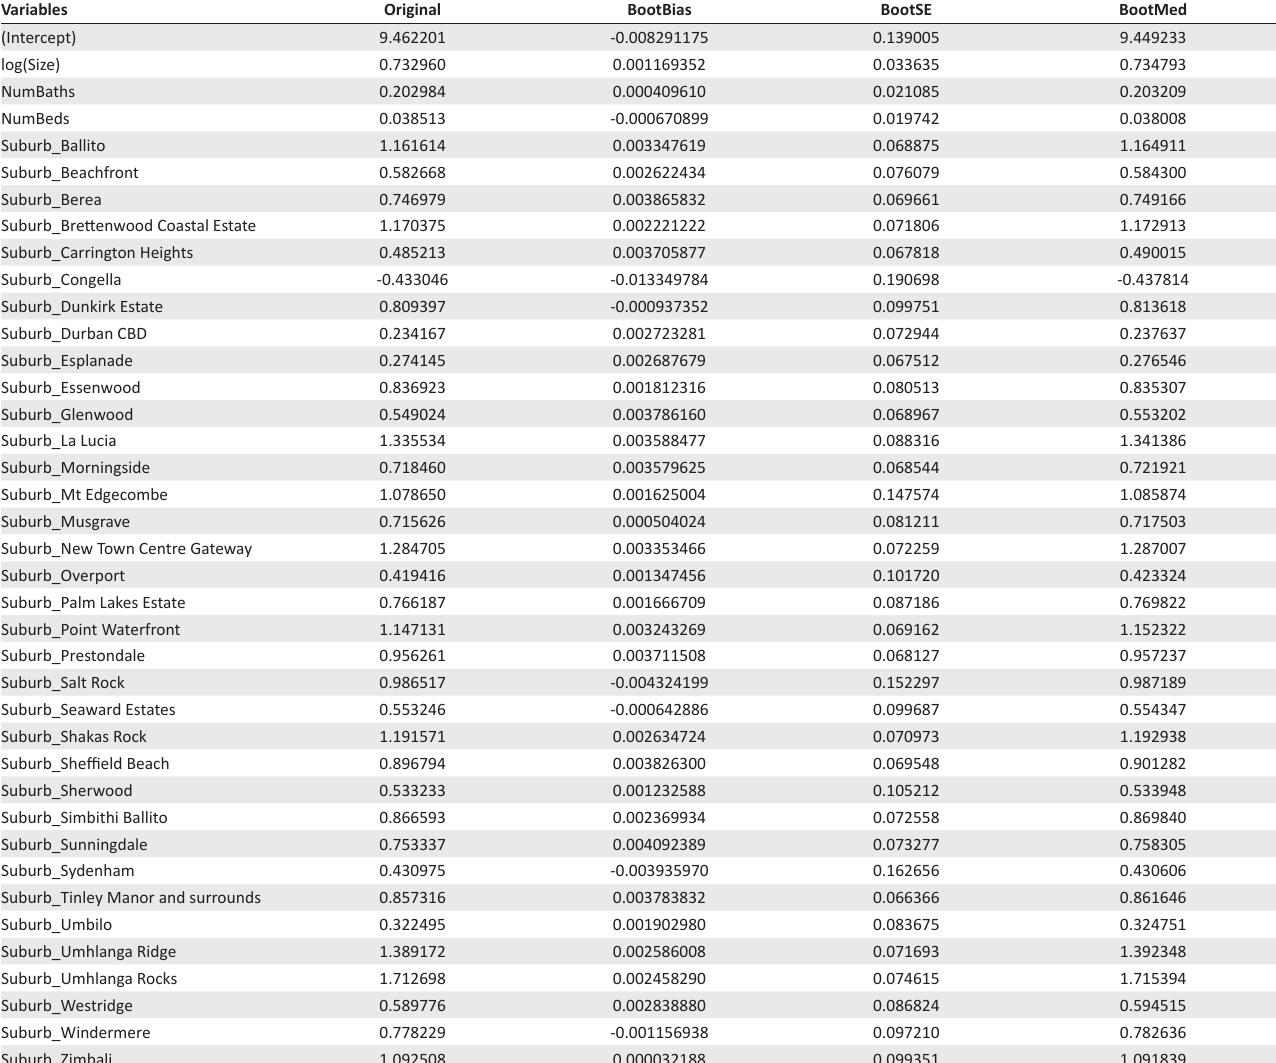
TABLE 5: Bootstrapped generalised linear